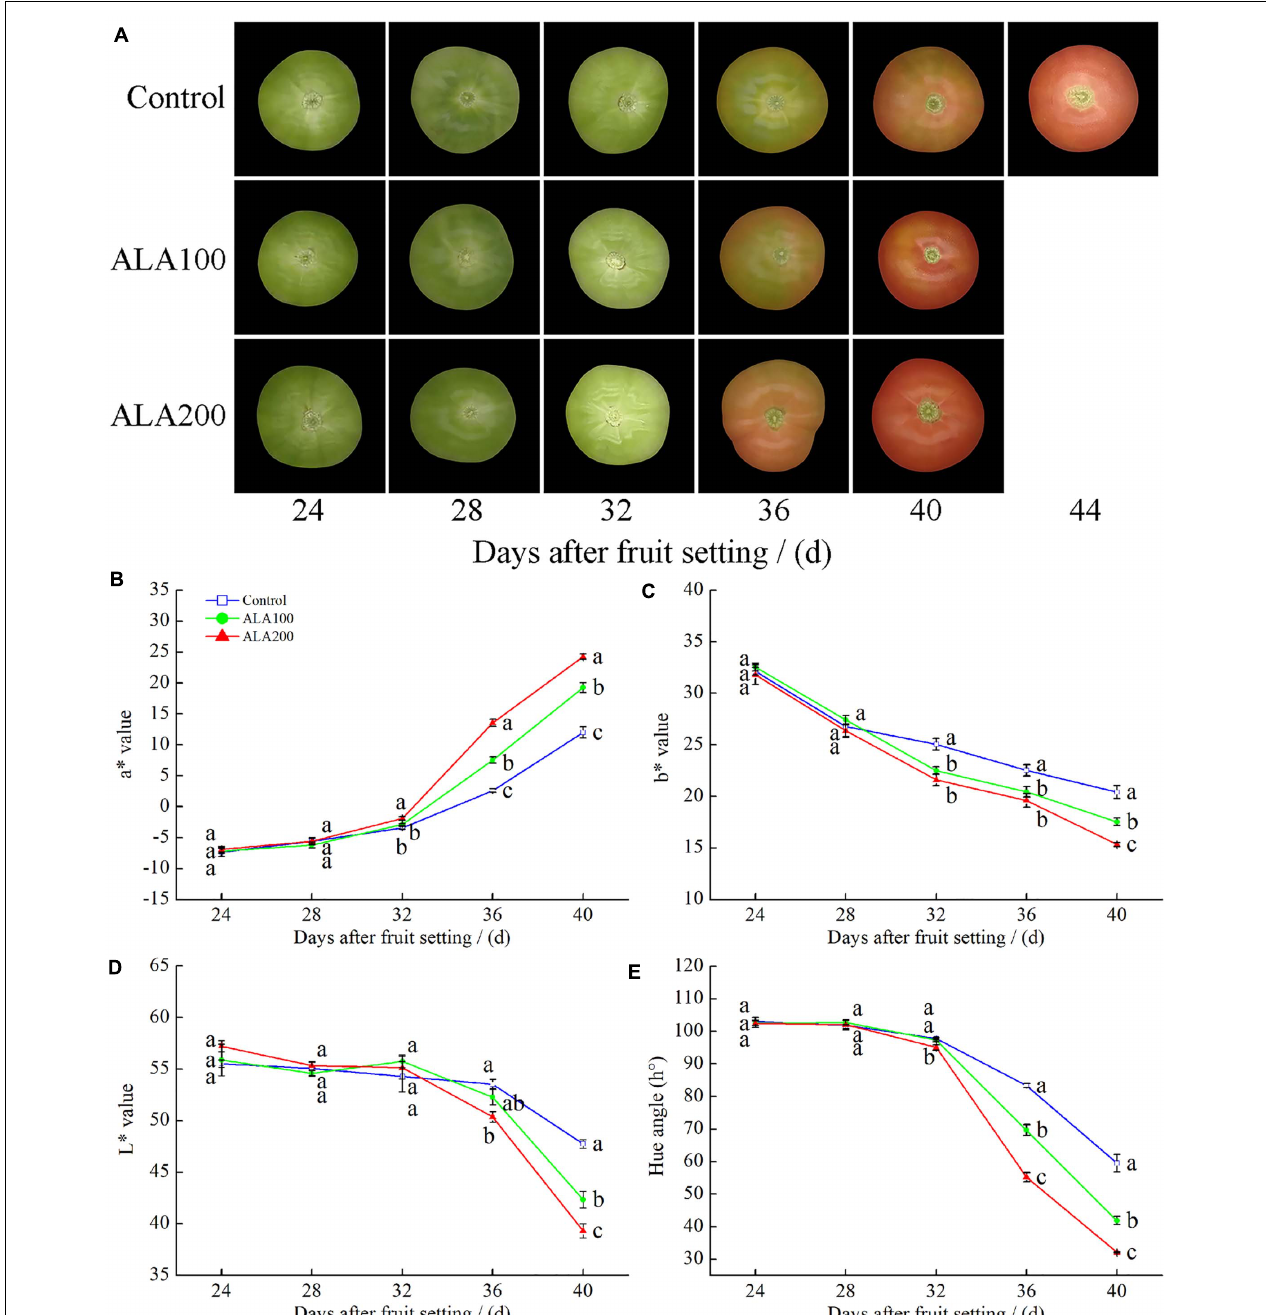
FIGURE 2 | The effects of ALA on morphology and skin color parameters of tomato fruits. (A) The fruit morphology; (B) the a ∗ value; (C) the b ∗ value; (D) the lightness; and (E) the hue angle of tomato fruits skin at 24th–40th day after fruit setting under different treatments. The data presented represent mean ± SE from three independent replicates and the different letters denote significant differences ( p <